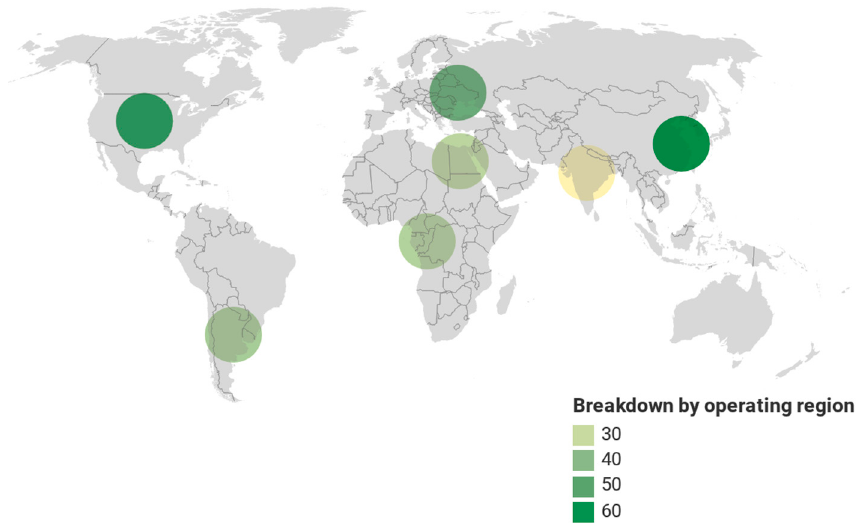
Figure 1. Map showing the contribution of blockchain projects to the SDGs per region. Source: Created by the authors based on data from [6].